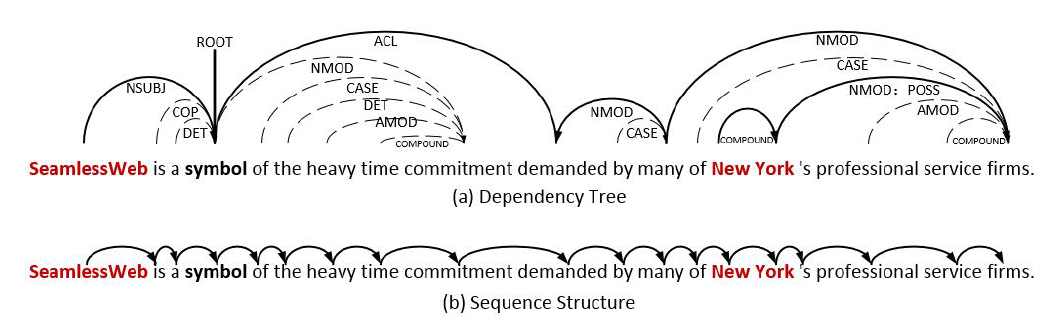
Figure 1. The example uses dependency tree and sequence structure to obtain sentence semantic, and assist in extracting relations between entities (indicated in red). In ( a ), the dependency tree can clearly express the dependency relationship between words in the sentence. Specifically, it analyzes and recognizes the grammatical components such as “subject-predicate-object” and “fixed adverbial complement” in the sentence. Each node is representing a word. In ( b ), the words in the sentence are read sequentially, usually from the left to the right, such as LSTM and GRU, while there are also two-way sequential reading forms, such as BiLSTM and